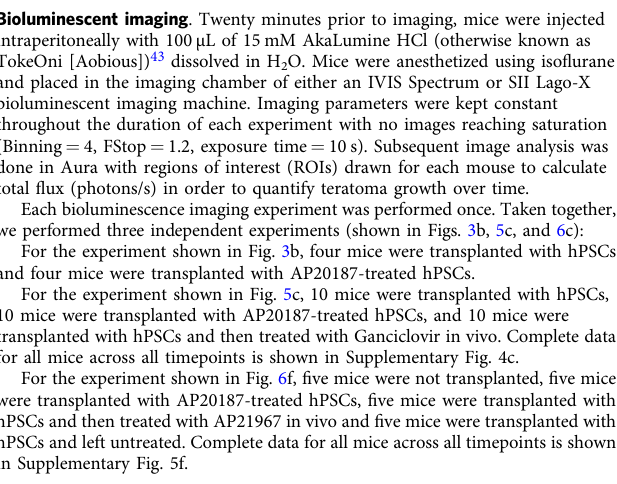
Supplementary Table 2. Flow cytometry was performed on a Beckman Coulter CytoFlex analyzer (Stanford Stem Cell Institute FACS Core). For data analysis, cells were gated based on forward and side scatter with height and width used for doublet discrimination. Subsequently, cells were gated for all marker analyses and calculations of population frequency. Each intracellular fl ow cytometry experiment was performed once, with two biological replicates assessed per